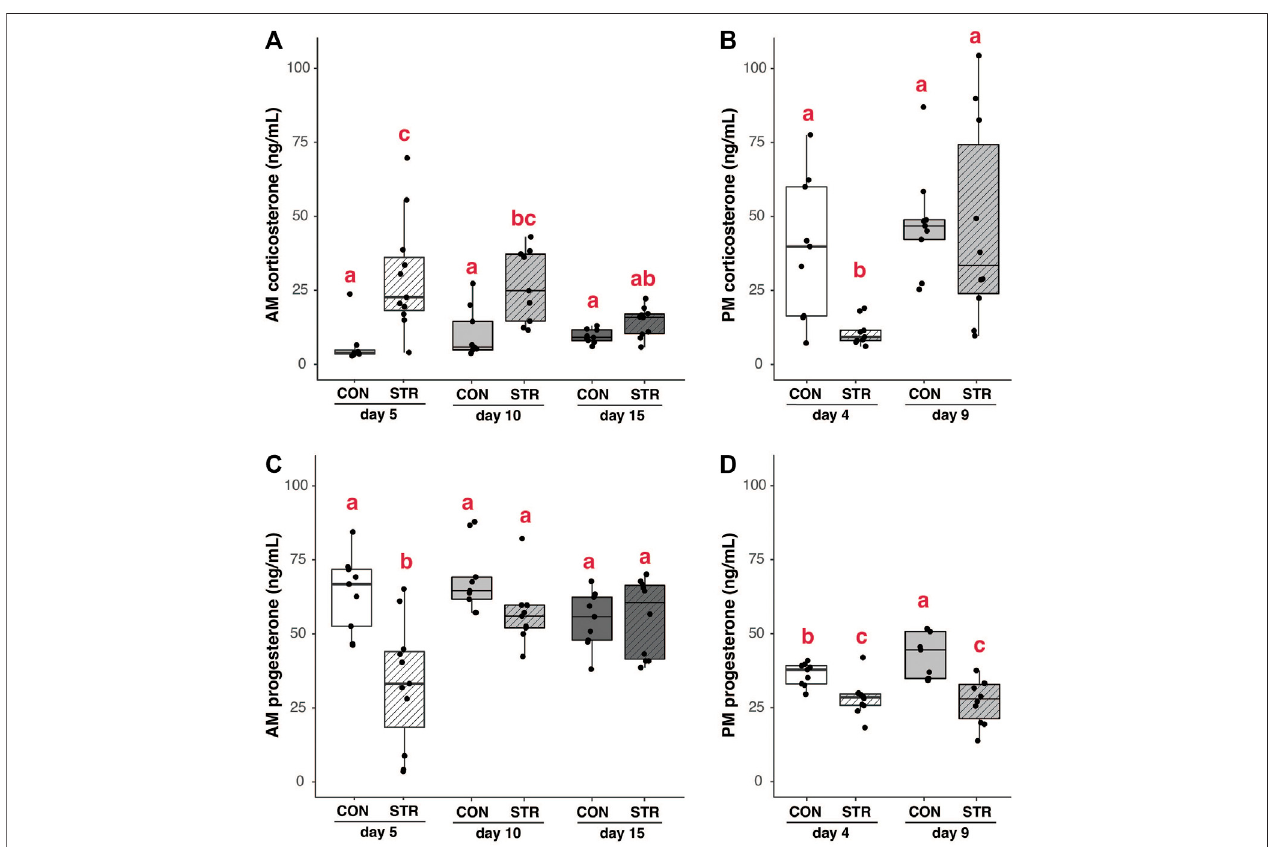
FIGURE 5 | Steroid hormones are modulated by chronic stress and gestation. (A) Morning baseline corticosterone concentrations were elevated in chronically- stressed mice on day 5 and 10 of pregnancy, but not on day 15 of pregnancy. (B) In the evening, corticosterone was suppressed in chronically stressed dams during early pregnancy (day 5), but unaltered during mid-pregnancy. (C) Morning progesterone was lower in chronically stressed dams during early pregnancy, but was unaffectedbystressatlatertimepoints. (D) Eveningprogesteronewaslowerinchronicallystresseddamsduringbothearly-andmid-pregnancycomparedtonon- stressed mice. Different letters indicate signi fi cant differences ( p < 0.05) in post-hoc analyses using the Bonferroni-Holm correction for multiple comparisons.